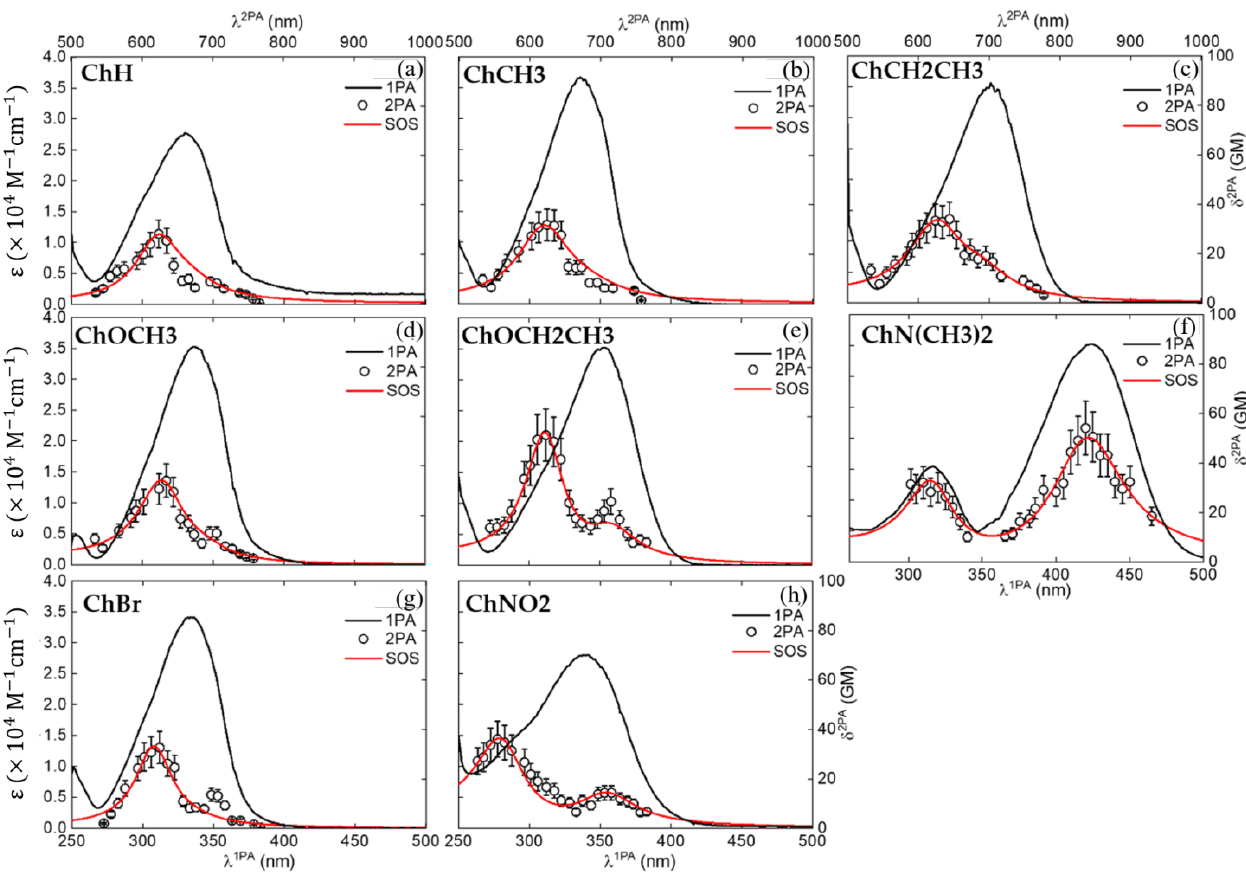
Figure 2 . One-photon absorption spectrum (continuous black lines) and 2PA spectrum measured through the tunable Z-Scan technique (circles) of ( a ) ChH , ( b ) ChCH3 , ( c ) ChCH2CH3 , ( d ) ChOCH3 , ( e ) ChOCH2CH3 , ( f ) ChN(CH3)2 , ( g ) ChBr, and ( h ) ChNO2 . The experimental error associated with 2PA measurements is 20%. The red lines represent the SOS model used to model the experimental 2PA results .